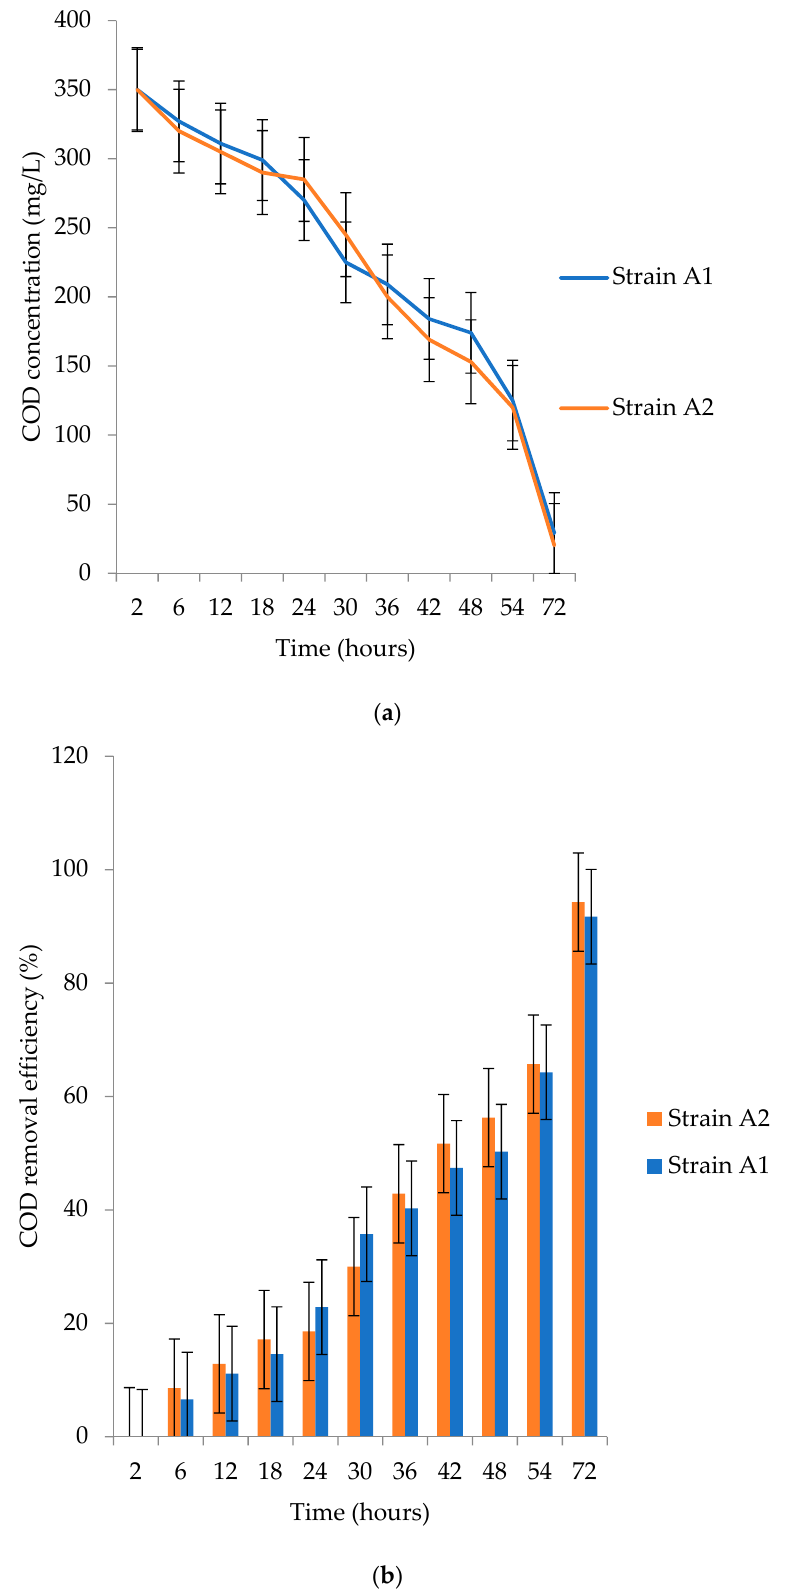
Figure 7. COD analysis results. ( a ) COD concentration (mg/L) and ( b ) COD removal efficiency within 72 h achieved from strains A1 and